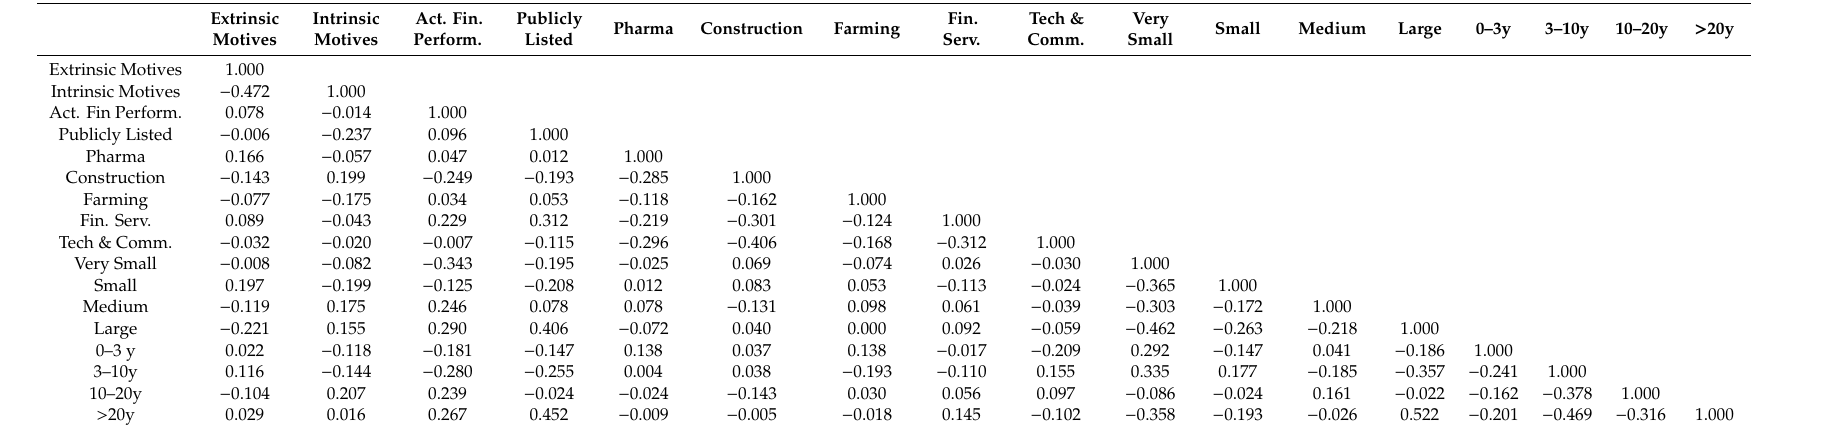
Table 5. This table presents the correlation matrix of all independent